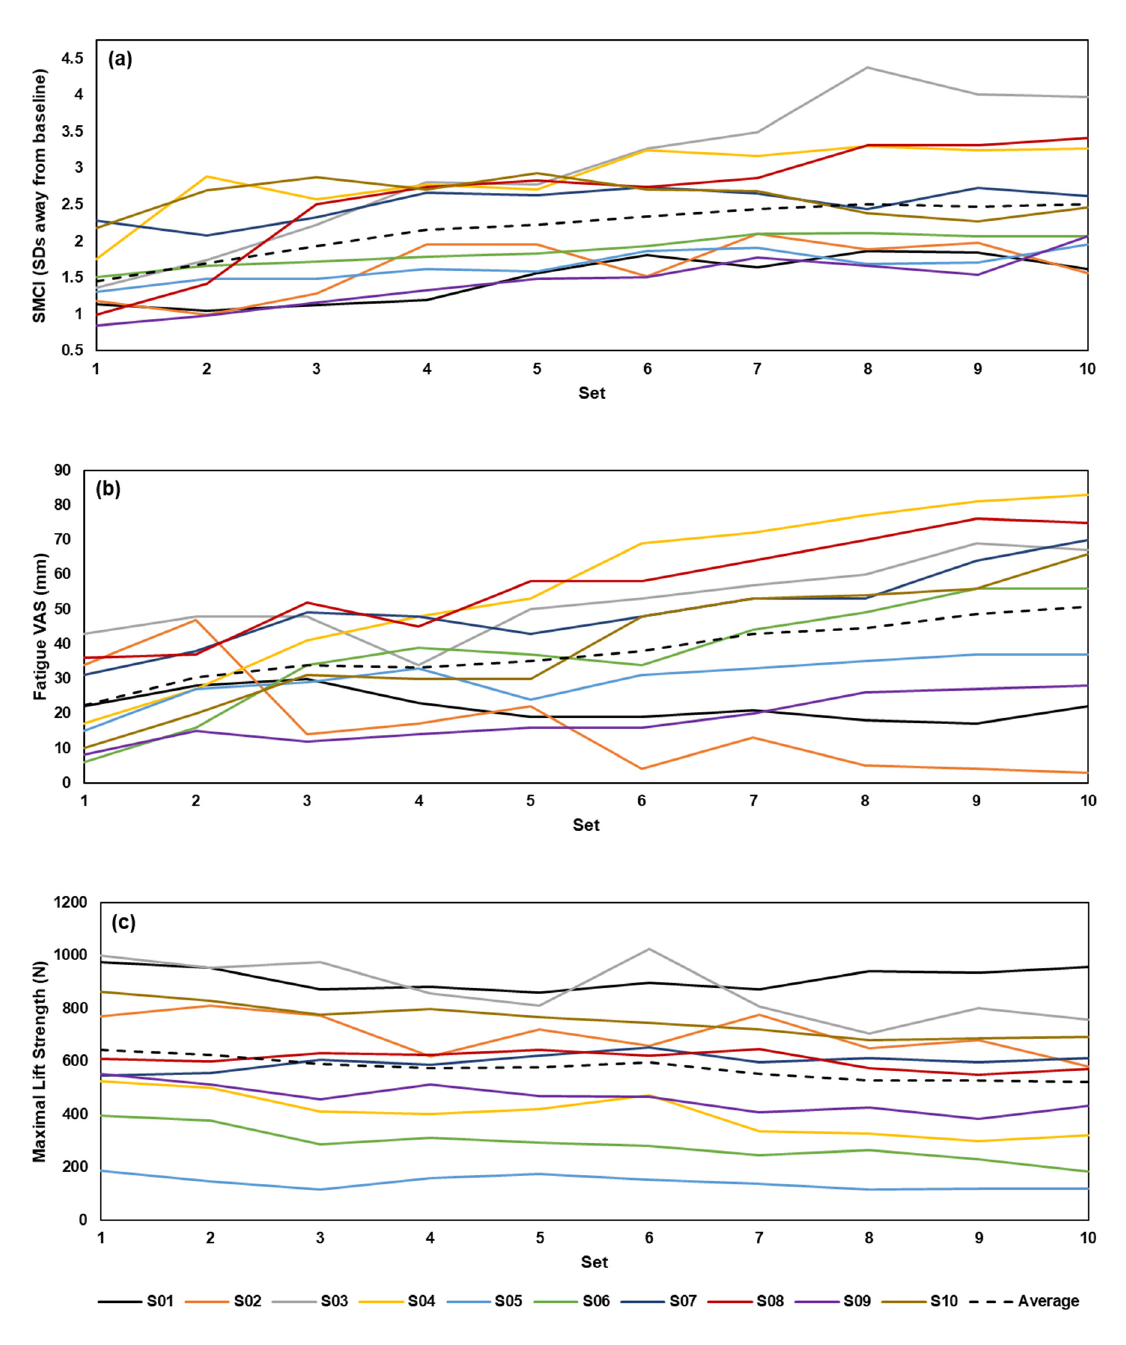
Figure A2. Individual responses in ( a ) spine motion composite index (SMCI), ( b ) fatigue visual analogue scale (VAS), and ( c ) maximal lift strength to the global trunk muscle fatigue for sets 1–10. Participants are identified as S01–S10. The average response for each dependent variable is shown with a dashed line.